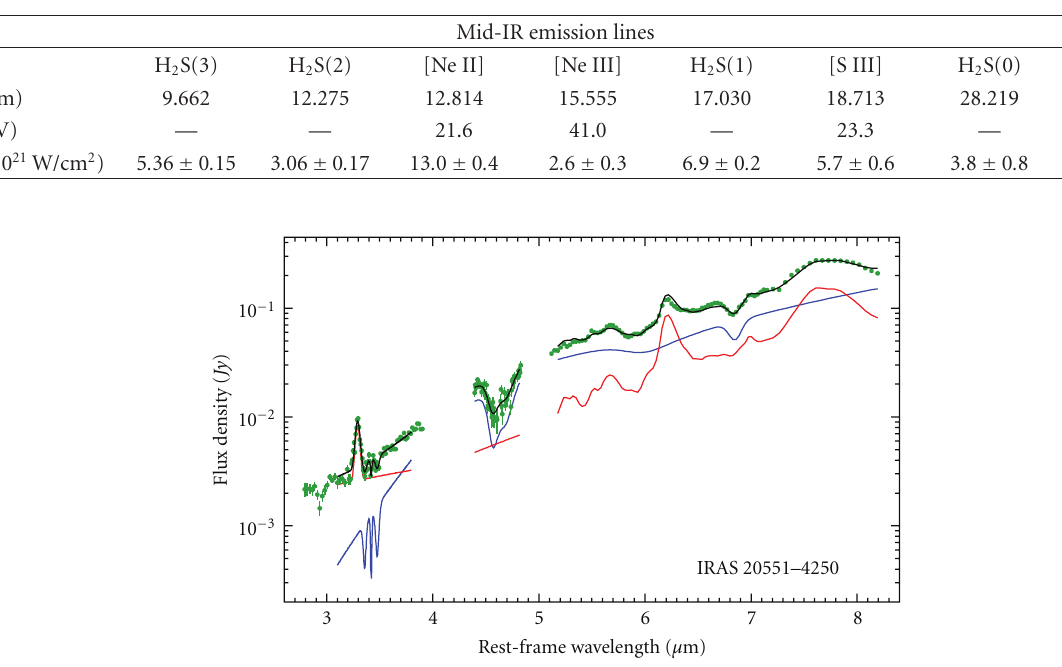
Table 1: Properties of the detected mid-IR emission lines. We measured the fluxes with the idl package smart by means of a Gaussian fitting. We use the most recent version of the IRS pipelines; thus our estimates are more reliable than those previously published.